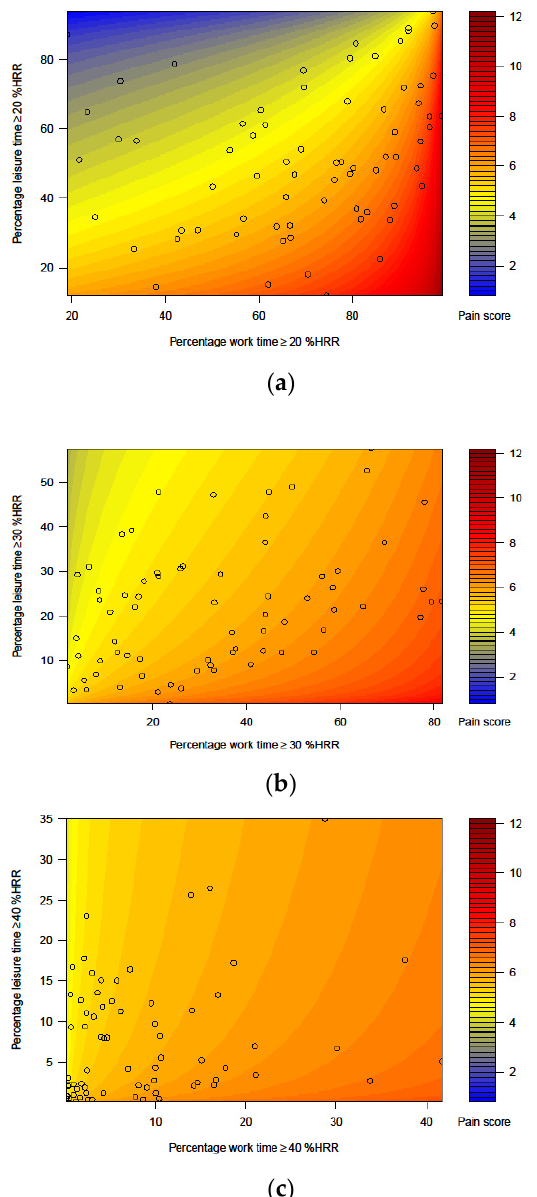
Figure 3. Heat maps illustrating the predicted average overall musculoskeletal pain score (scale from 0 to 27) over the 2-year follow-up at different baseline percentages of time ( a ) ≥ 20 %HRR, ( b ) ≥ 30 %HRR, and ( c ) ≥ 40 %HRR at work and during leisure. In each panel, the black circles show individual, observed compositions of time at work and in leisure. The figures illustrate the pain score according to the regression model only within the range of compositions represented in the sample ( n =